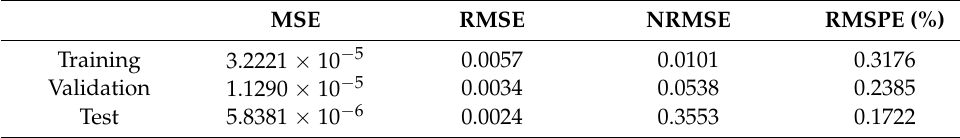
Table 4. Performance indices of the LM-BPNN